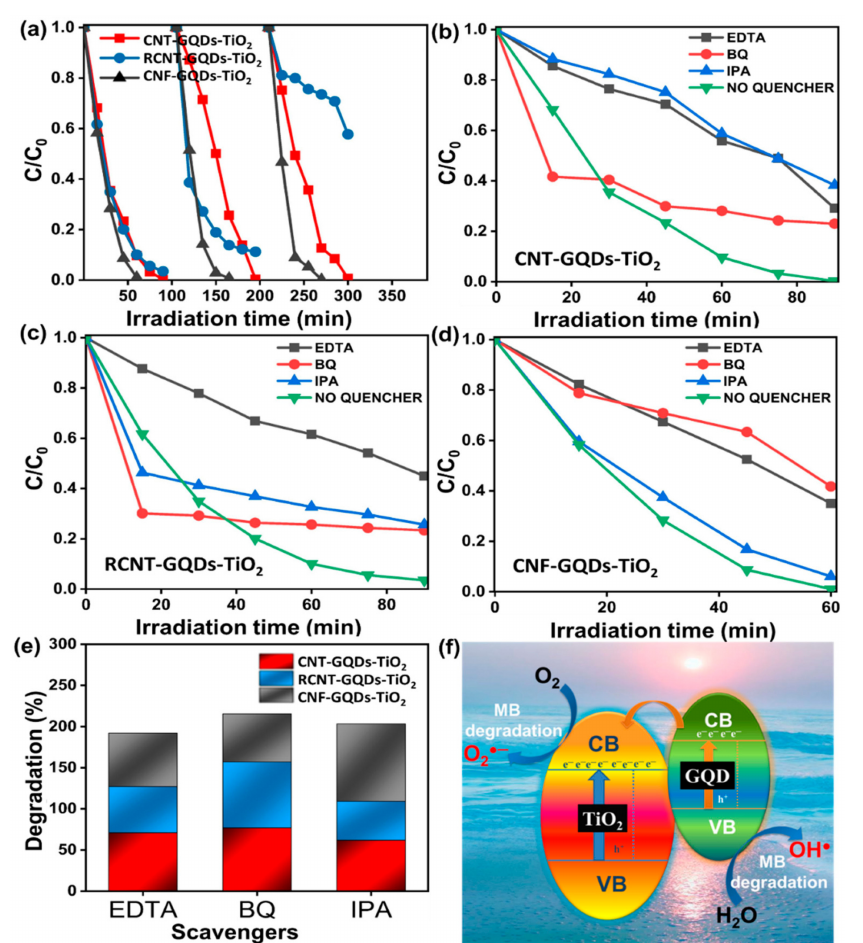
Figure 6. ( a ) Cyclic runs of MB degradation under visible light exposure for GQDs-TiO 2 nanocom- posites. MB degradation concentration in absence and presence of different scavengers